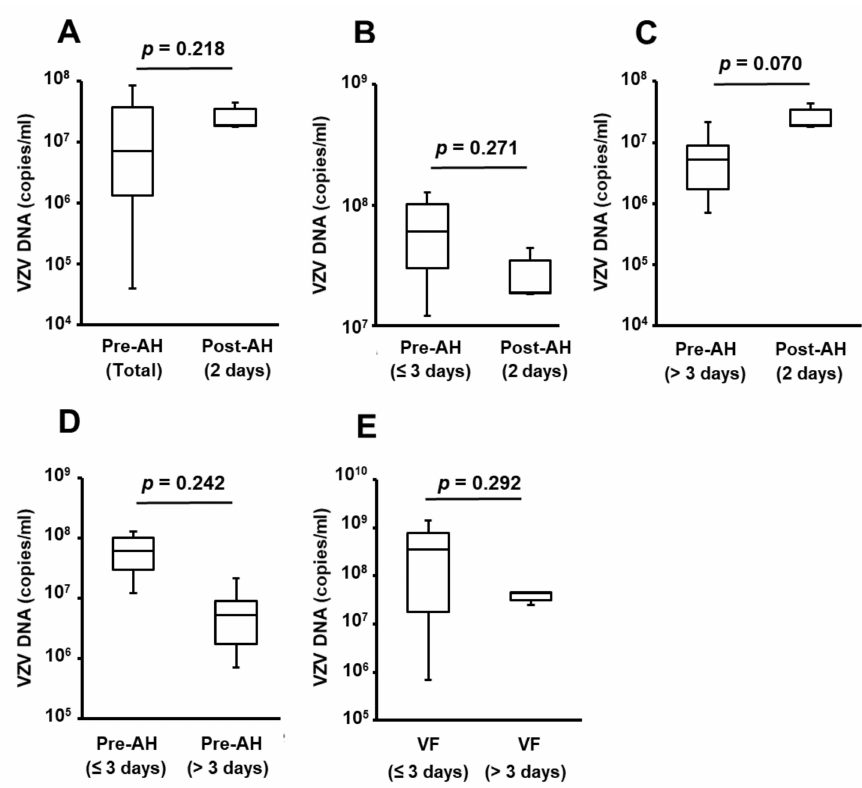
Figure 2. Comparisons of viral loads in ocular fluids before and after initiation of intravenous acyclovir treatment. Comparisons of viral loads between ( A ) Pre-AH (Total) and Post-AH (2 days), ( B ) Pre-AH ( ≤ 3 days) and Post-AH (2 days), ( C ) Pre-AH ( > 3 days) and Post-AH (2 days), ( D ) Pre-AH ( ≤ 3 days) and Pre-AH ( > 3 days) and ( E ) VF ( ≤ 3 days) and VF ( > 3 days) are shown. The box plot represents the median, 25 / 75 percentiles, and 10 / 90 percentiles. Total: all of Pre-AH